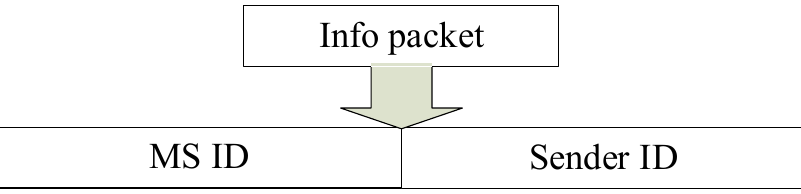
Figure 2. Info packet